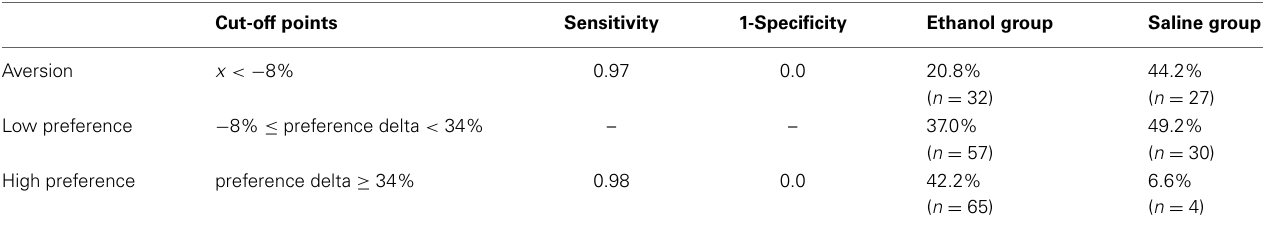
Table 1 | Cut-off points for each cluster (based on preference delta) along with the respective sensitivity and 1-specificity values, generated by ROC curve